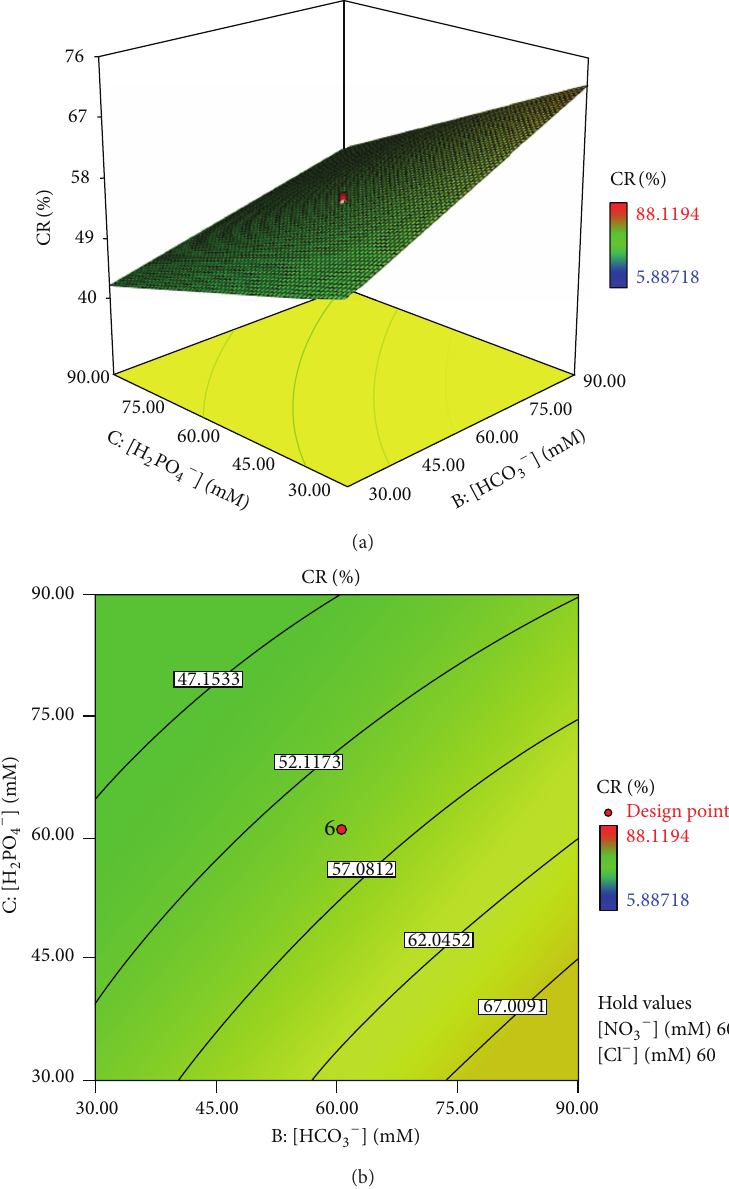
Figure 5: Response surface (a) and contour plots (b) of the removal efficiency (%) as a function of HCO 3− and H 2 PO 4−